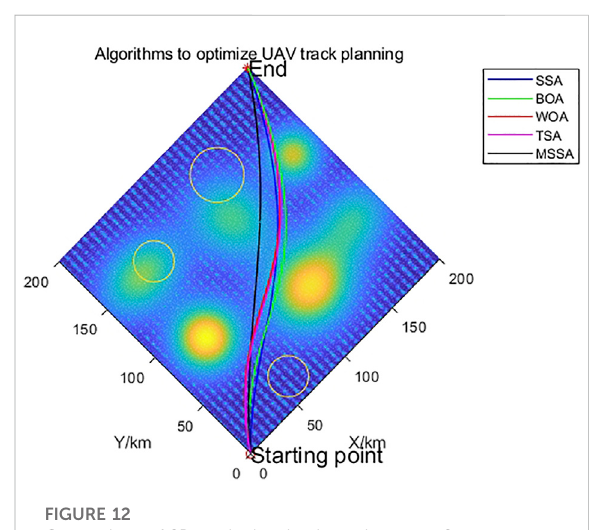
FIGURE 13 Convergence diagram of track cost function in environment